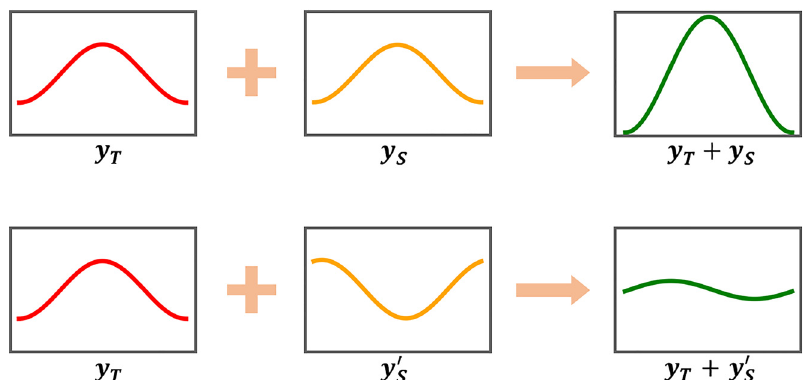
Figure 2: Superposition of two samples. The red and orange curves represent the distribution of samples in target domain and source domain, respectively, while the greenlinescorrespondtothesuperposition of these two